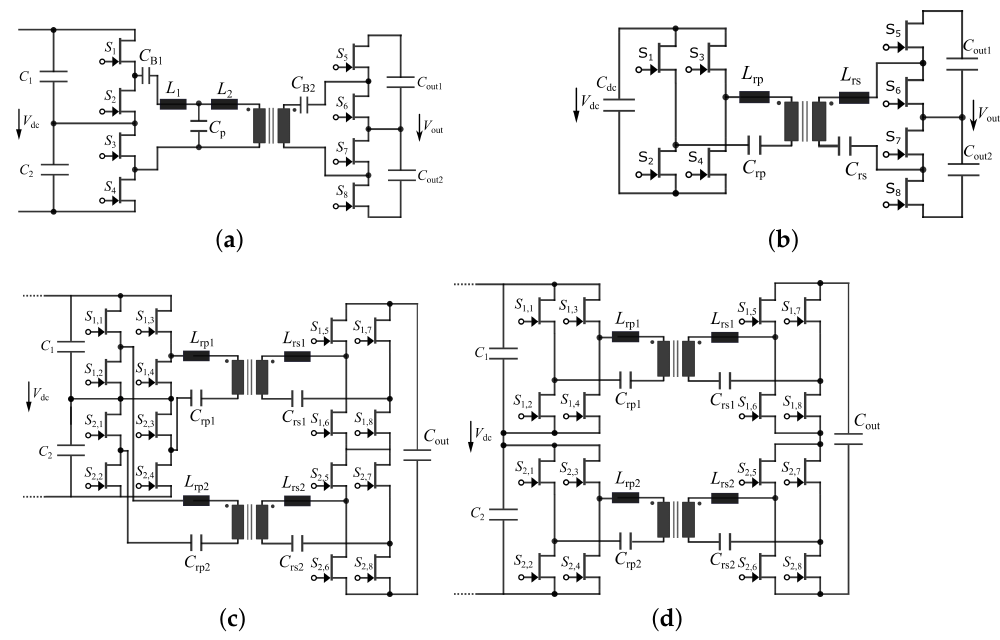
Figure 22. Multi-level DC/DC resonant converters proposed in the literature. ( a ) LCL-T resonant converter (edited from [94]) and conceptual ( b ) DAB converter with series stacked half-bridge secondary, ( c ) Stacked half-bridge ( d ) and its symmetrical full-bridge variant for 800 V EV charging applications (edited from [106]).